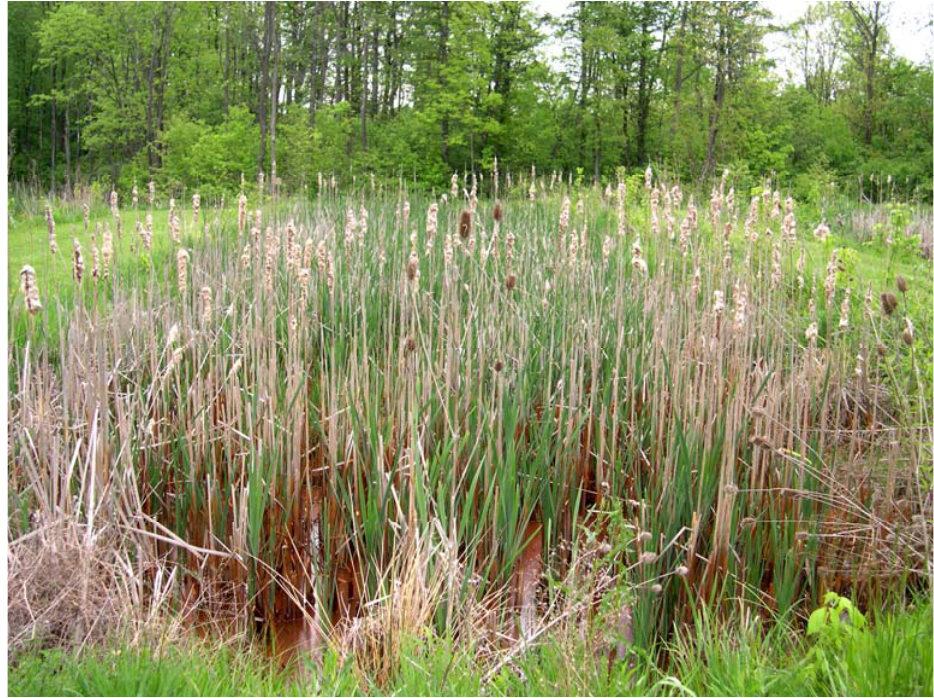
Figure 3. A FWS CW for treatment of alkaline mine drainage waters in Monastery Run, Pennsylvania, U.S. Photograph taken by the author.